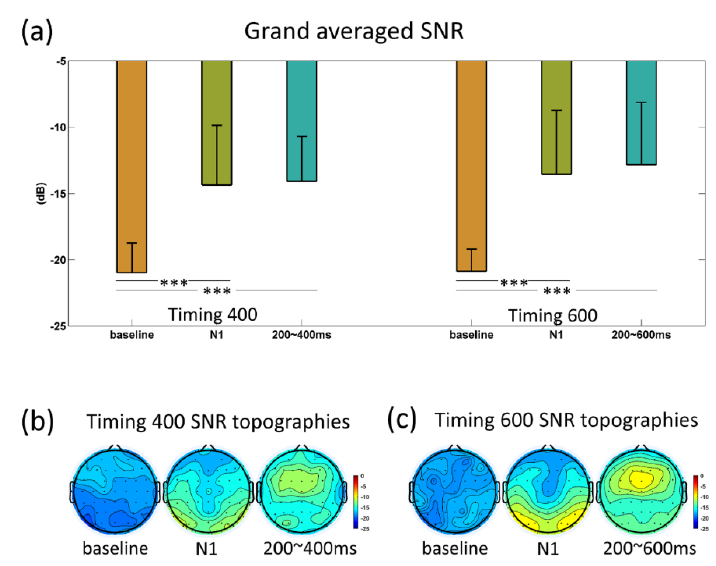
Figure 3. ( a ) SNR values of baseline, N1, 200~400 ms in timing 400 (left); SNR values of baseline, N1, 200~600 ms in timing 600 (right); ( b ) timing 400; ( c ) timing 600 SNR topographies. Statistical significance: *** P < 0.001.